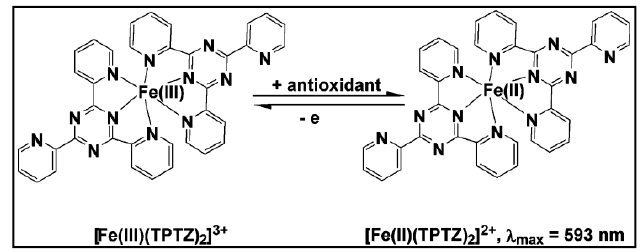
Figure 9. FRAP—electron-transfer reaction.